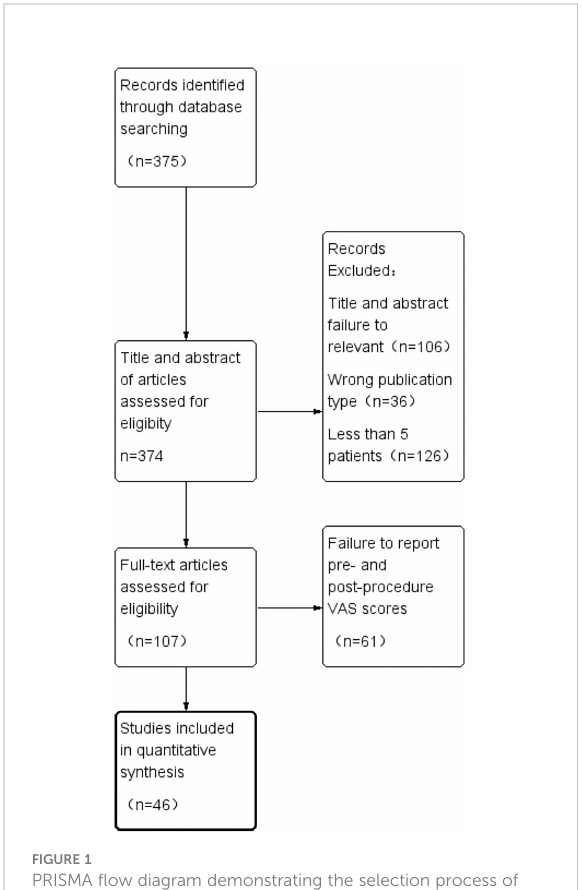
FIGURE 1 PRISMA fl ow diagram demonstrating the selection process of